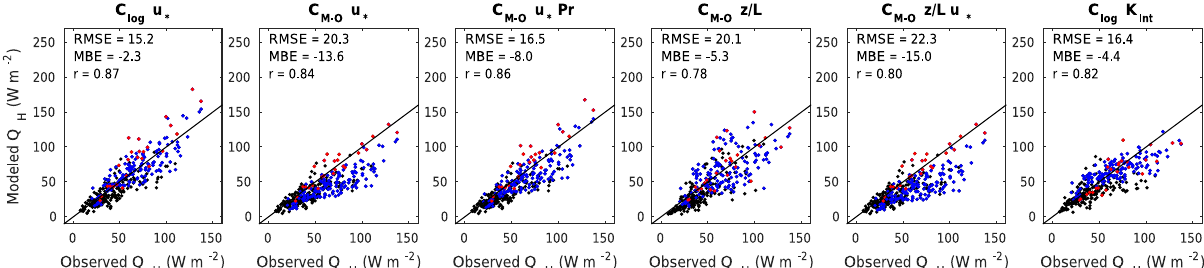
Figure 8. Comparison of 30min values of observed (OPEC-derived) and modeled sensible-heat flux ( Q H ) using six different bulk methods: C log u ∗ , C M − O u ∗ , C M − O u ∗ Pr , C M − O z flow conditions.